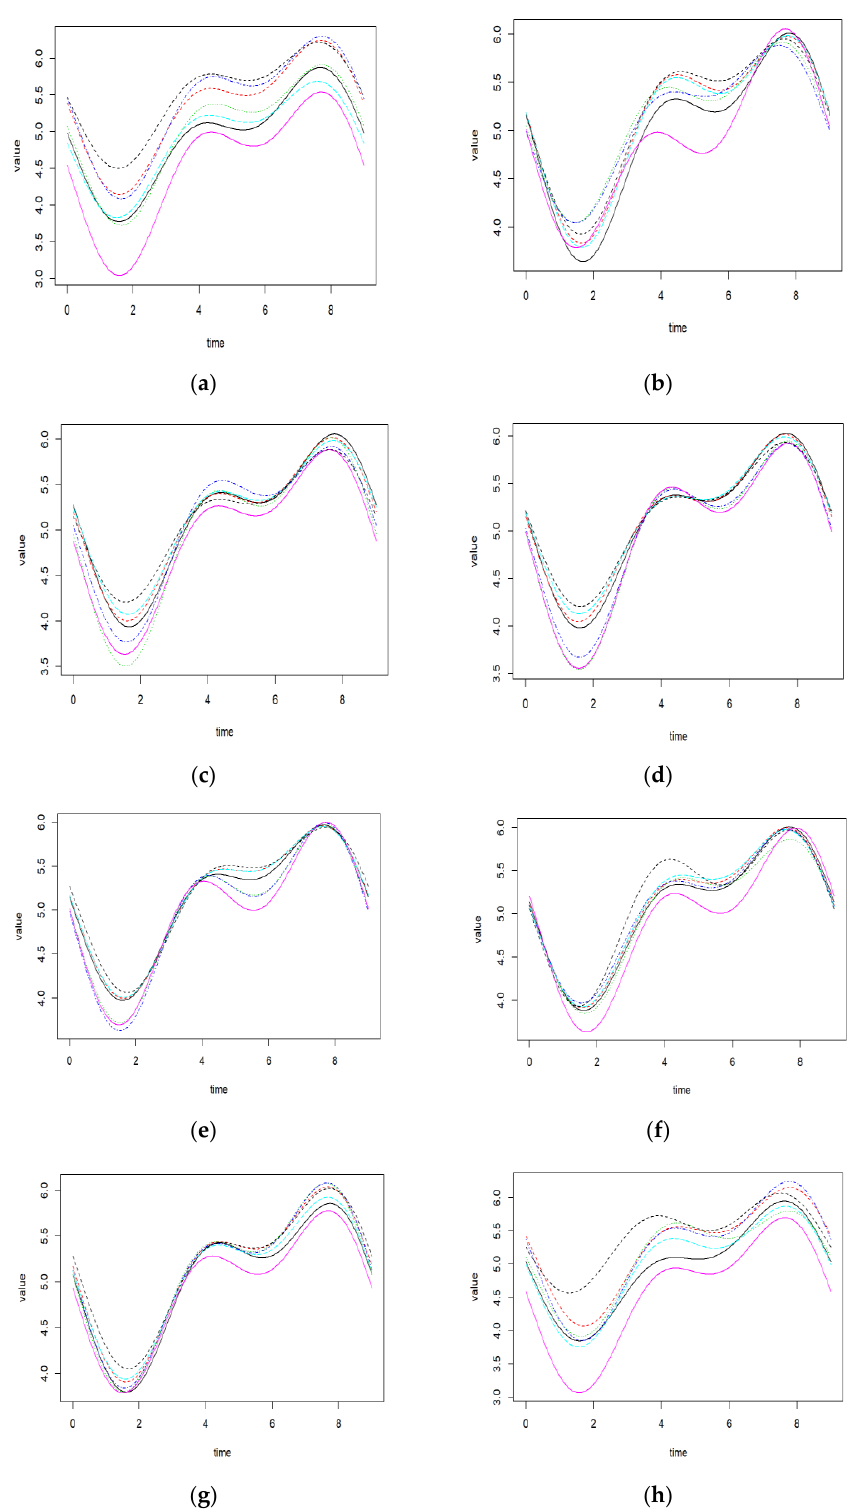
Figure 5. Plots for actual observations and predicted values. ( a ) Actual values for onion weights, ( b ) predicted values for weights by wind speed, ( c ) predicted values for weights by mean temperature, ( d ) predicted values for weights by ground temperature, ( e ) predicted values for weights by humidity, ( f ) predicted values for weights by sunshine, ( g ) predicted values for weights by rain, ( h ) predicted values for weights by all